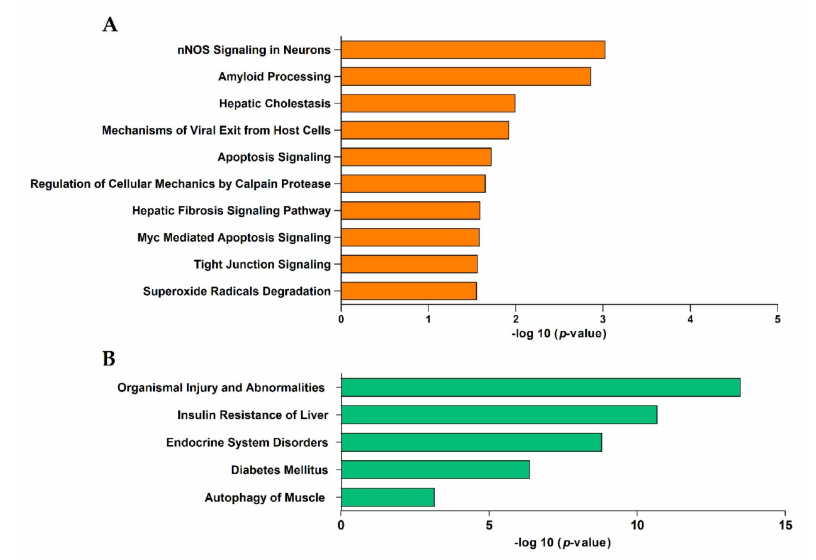
Figure 1. ( A ) The 10 most representative altered canonical pathways targeted by the di ff erentially expressed (DE) miRNA target genes associated with the risk of T2DM development, identified using Ingenuity Pathway Analysis (IPA) (FDR < 0.05). ( B ) Top 5 diseases associated with the DE miRNA target genes (IPA